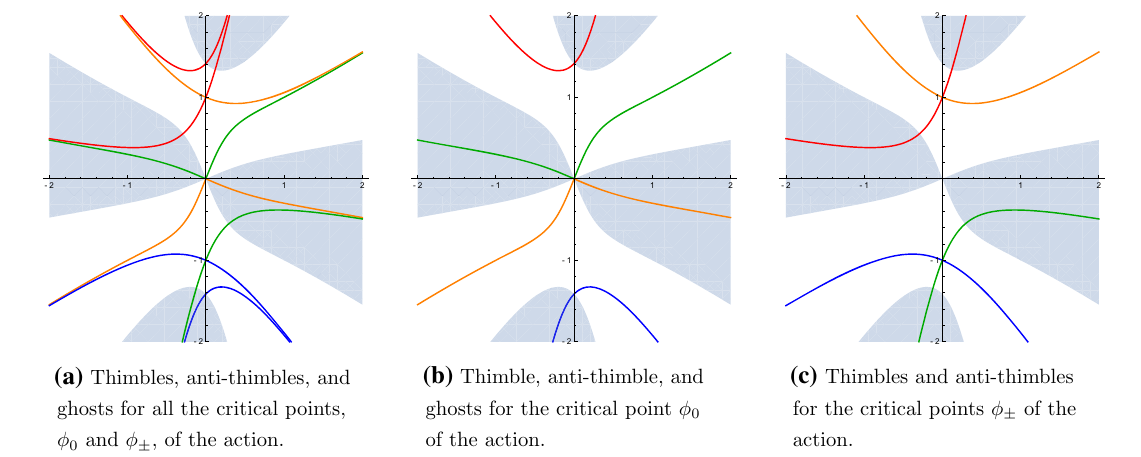
Fig. 6 Demonstration of piecewise behavior by the thimble solutions to Eq. (3.3), corresponding to φ 0 and φ ± , for the parameters { a = 1, b = 1, c = 1, d = 1, h = 0 } . In all the three figures, the blue solid